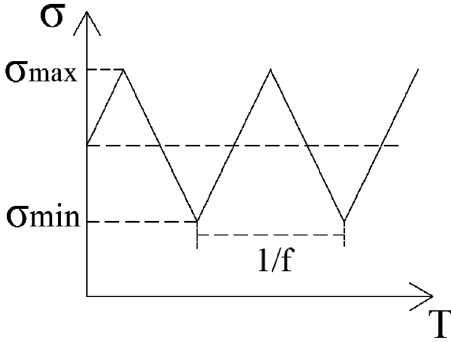
Figure 3: Load waveforms of the HCF